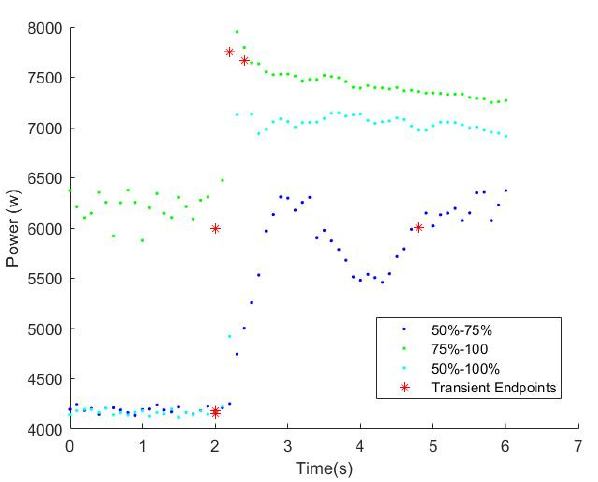
Figure 11. ATC transient throttle testing results.